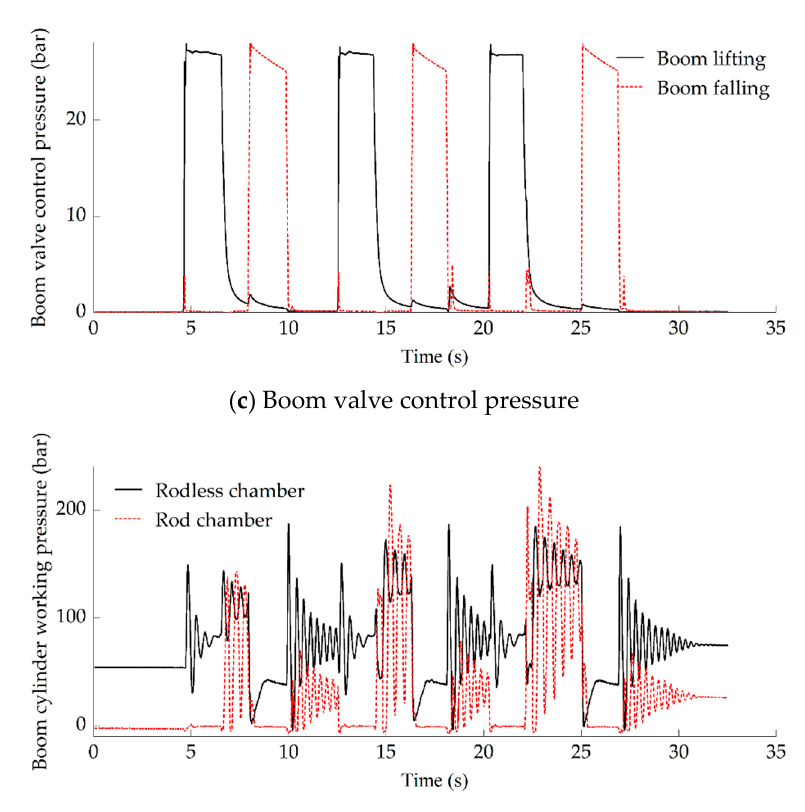
Figure 9. Operating characteristics of the LUDV swing-boom system.